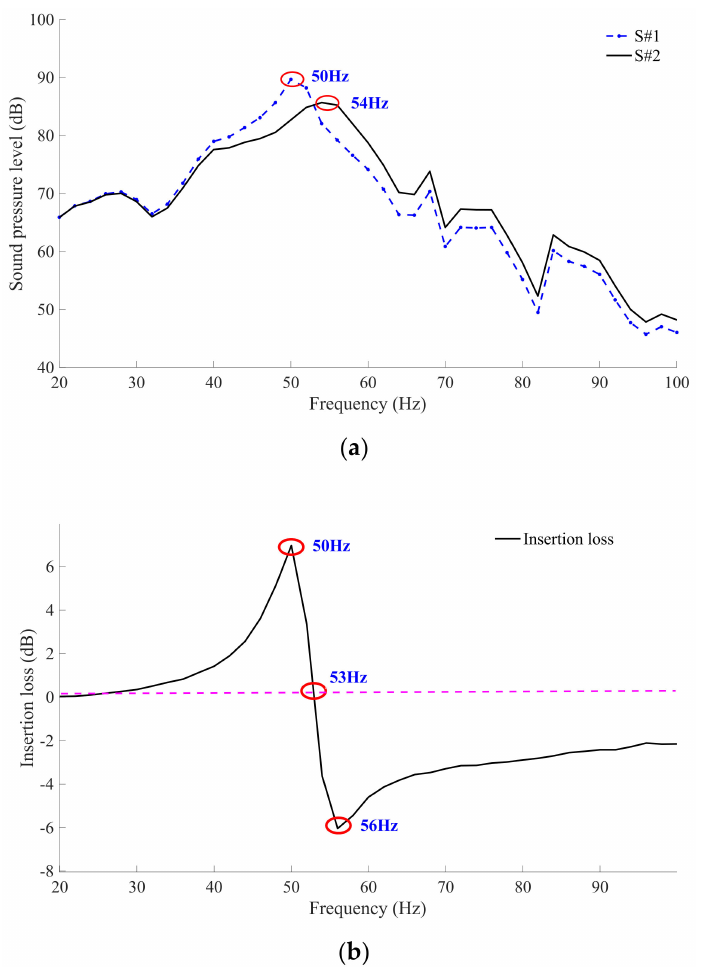
Figure 12. Sound pressure level and insertion loss at field point 4; ( a ) sound pressure level; ( b ) inser- tion